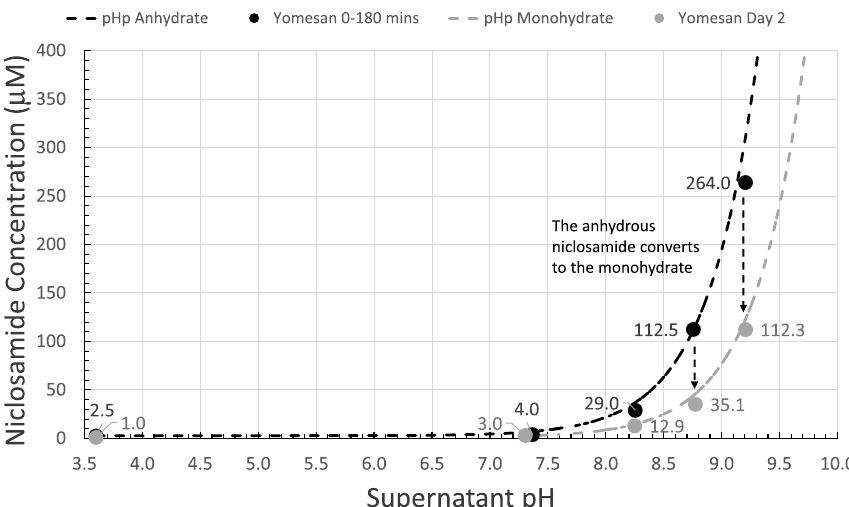
Fig. 10 Yomesan-niclosamide dissolution as a function of Tris buffer pH: Maximum niclosamide concentrations from Fig. 9 (filled black circles) vs. supernatant pH, plotted along with pHp theory determined earlier (Needham 2022) (dotted black line), for anhydrous (AK Sci) niclosamide (pKa 7.12, S w 2.53 µM). Also shown are the day 2 equilibrated concentrations (gray-filled circles) and pHp theory for the monohydrate (dotted gray = line) ( S w 1 µM) ( S w intrinsic solubility of the protonated niclosamide = =